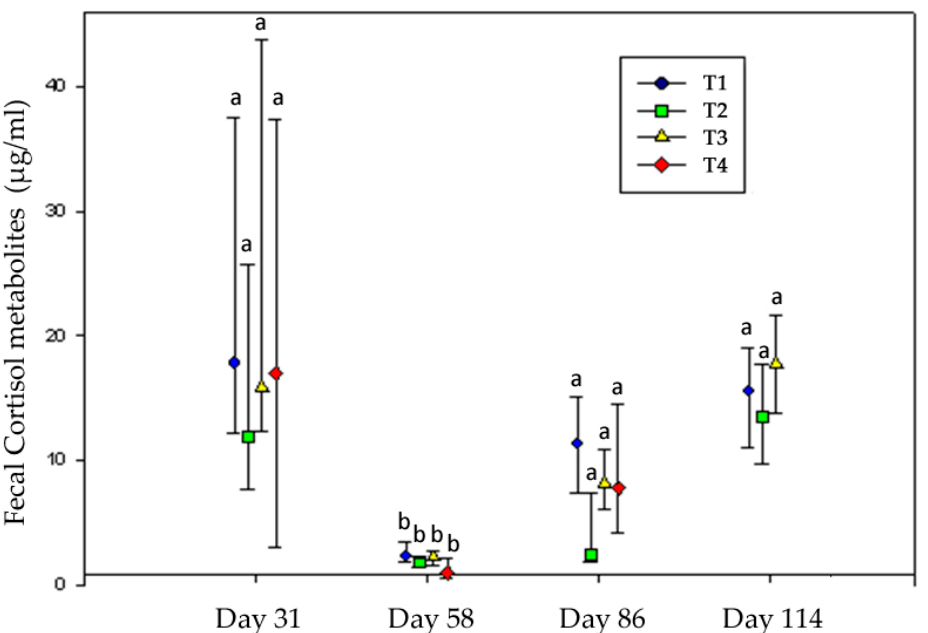
Figure 5. Fecal cortisol concentration in the different treatments throughout the experiment. Lines represent the median, 25th, and 75th percentile values. a,b Medians within the same treatment at different dates differ with p < 0.05. Animals from T4 were already slaughtered at day 114.